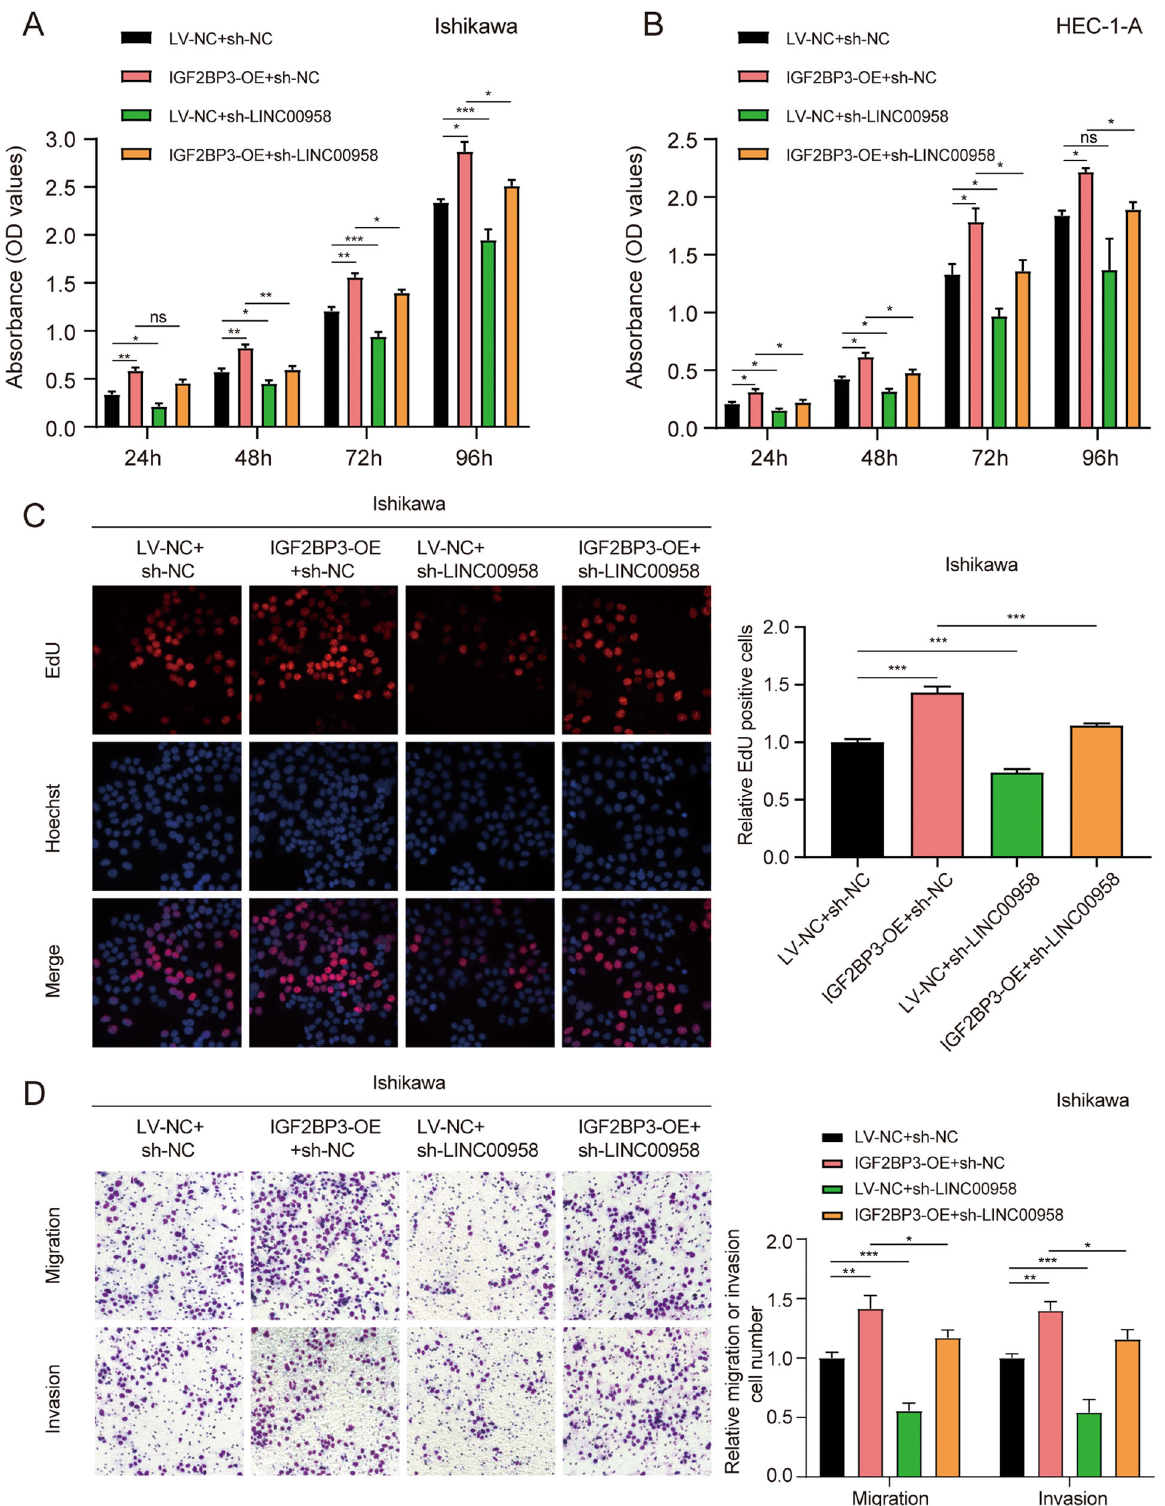
Fig. 4 Knockdown of LINC00958 offset the tumor-promoting role of IGF2BP3 in EC. A and B CCK-8 assays showed the proliferation of Ishikawa cells and HEC-1-A cells upon ectopic expression of IGF2BP3 combined with LINC00958-silenced expression. C EdU assays indicated the proliferation ability of Ishikawa cells stably transfected. D Migration and invasion assays showed invasion in Ishikawa cells stably transfected. On the right side of representative images are their quanti fi cation results. * P < 0.05, ** P < 0.01, *** P < 0.001, “ ns ” , no statistical signi fi cance. Data, mean ± S.D. All experiments were independently repeated with at least three replicates.